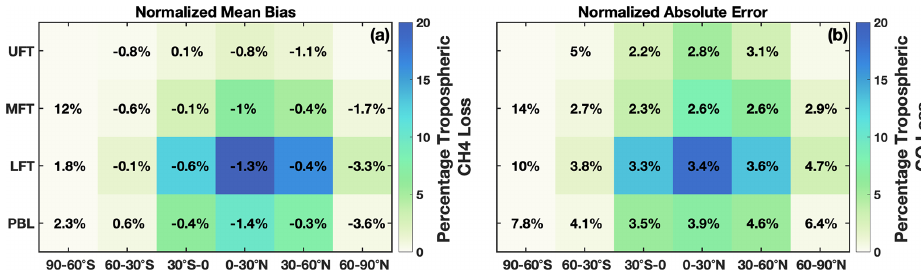
Figure 3. (a) Percentage of total tropospheric CH 4 lost to reaction with OH for July 2005 averaged over 30 ◦ zonal mean bins and four atmospheric layers is shown by the background colors. The percentage loss values account for the mass of each region relative to the total atmospheric mass. Percentages indicate the normalized mean bias of the parameterization with respect to the MERRA2 GMI simulation. Statistics for the polar UFT are omitted because low tropopause heights limit the data amount in these regions. Panel (b) is the same as panel (a) except it is for tropospheric CO loss and the normalized absolute